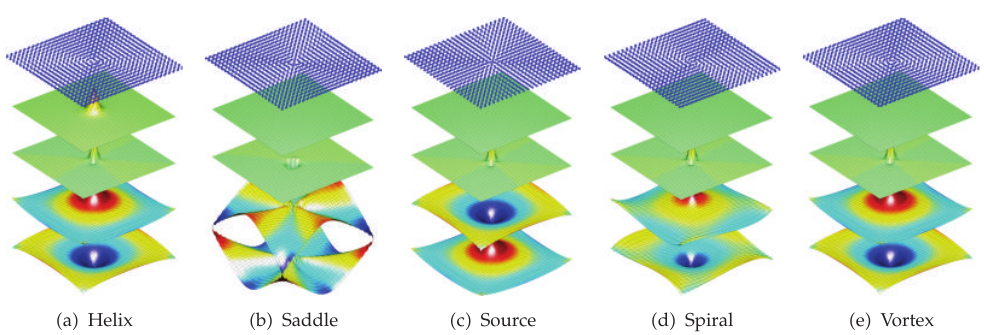
Figure 1: Second-order tensor field features and surface plots of the functions whose critical points identify them. From top to bottom, the functions are trace of helicity, divergence of the Lamb vector, trace of irrotational component, and trace of solenoidal component. The irrotational and solenoidal parts are computed from the generalized Helmholtz